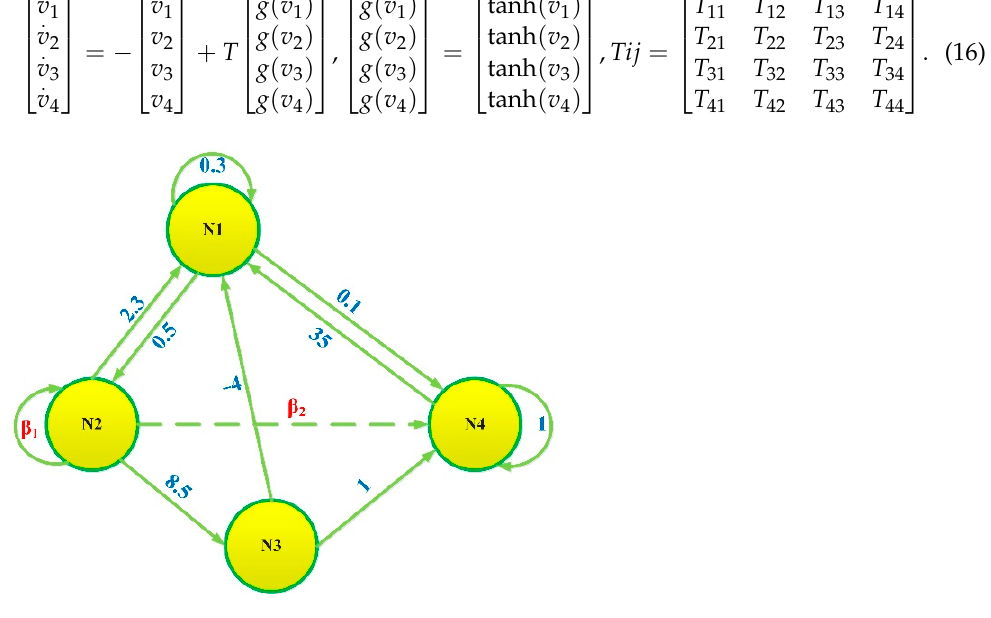
Figure 1. The topology structure of the neural network. Setting R i = 1, I i = 0, the Equation (16) describes the model, based on four neurons. In this case, the v is a vector containing the four elements with the four state variables. Two variable synaptic weighting parameters are set, namely β 1 and β 2 . By choosing